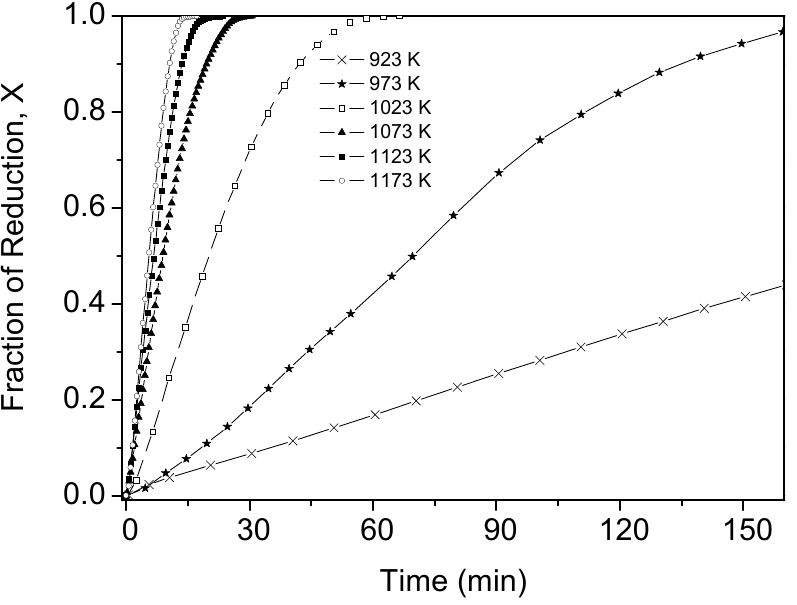
Figure 8. Experimental values of the fractional reduction of Fe 2 MoO 4 by hydrogen in a fluidized bed reactor.